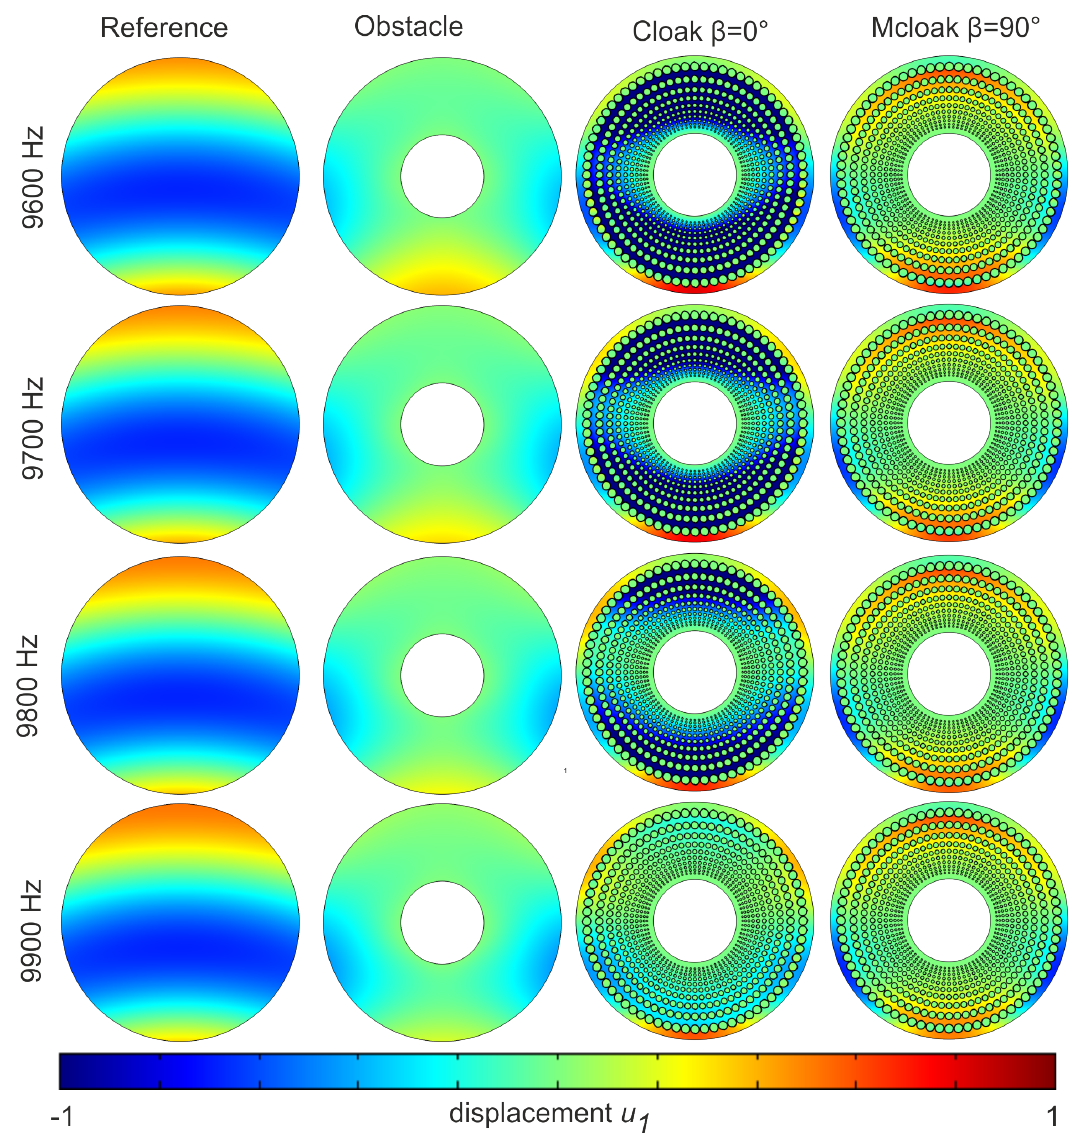
Figure 3. Field plots as in Figure 2 but shown only around the cloak’s